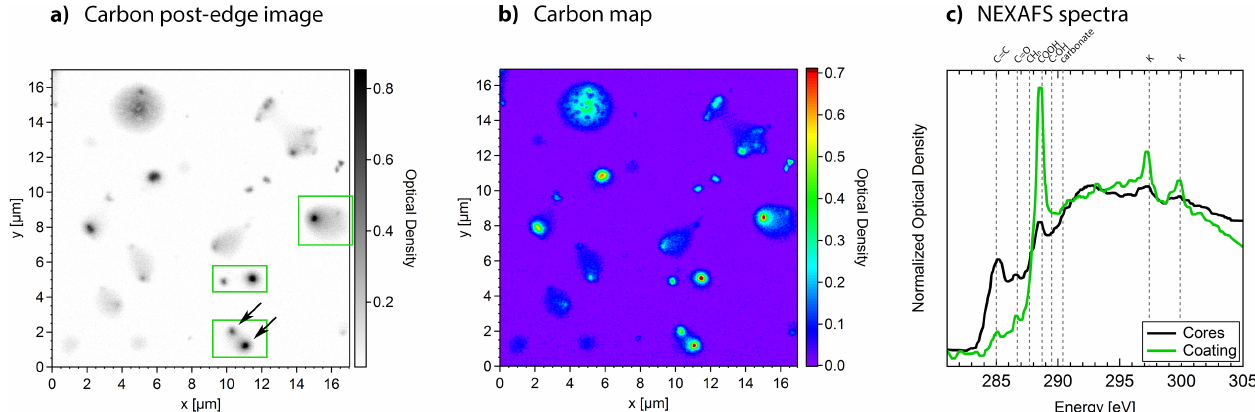
Figure 32. STXM images and elemental maps with corresponding NEXAFS spectra of aerosol particles collected at the ATTO site during a period with anthropogenic pollution. (a) Carbon post-edge image (293eV) of a characteristic region showing internally mixed droplet-like particles with cores (black arrows) and coatings of variable thickness (green boxes). (b) Carbon elemental map (pre-edge 280eV, post-edge 293eV) showing the distribution of carbonaceous material. (c) NEXAFS spectra showing high abundance of pi- (C = C) and keto (O = C) functional groups in cores. Coating reveals high abundance of carboxylic acid groups (CCOH) and weaker signals for keto and pi